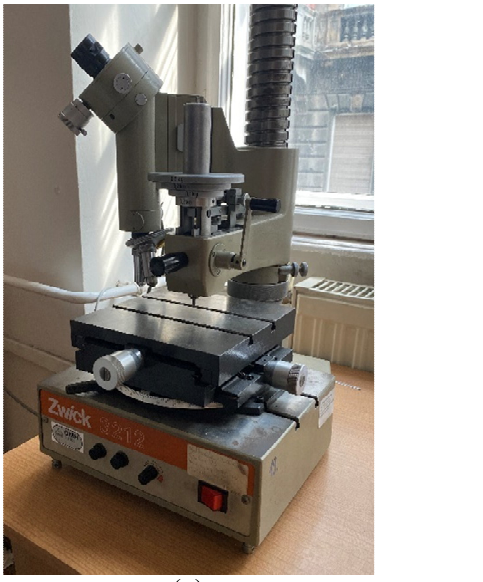
Table 3. Data input for the furnace charge diagram.